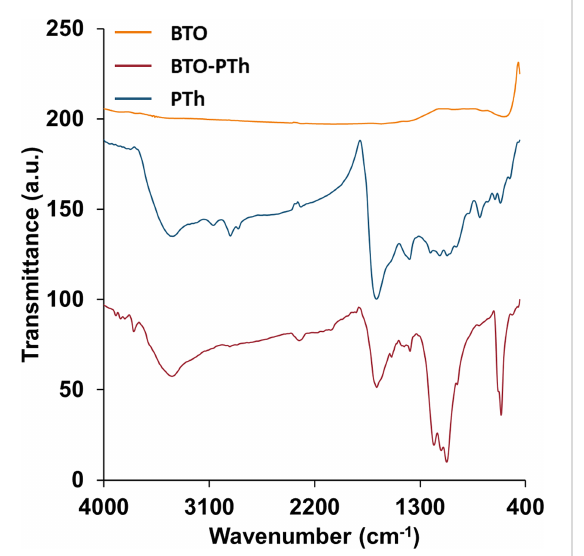
Figure 2: FTIR spectra of the as-prepared BTO nanoparticles, pristine PTh, and core–shell BTO-PTh nanoparticles.